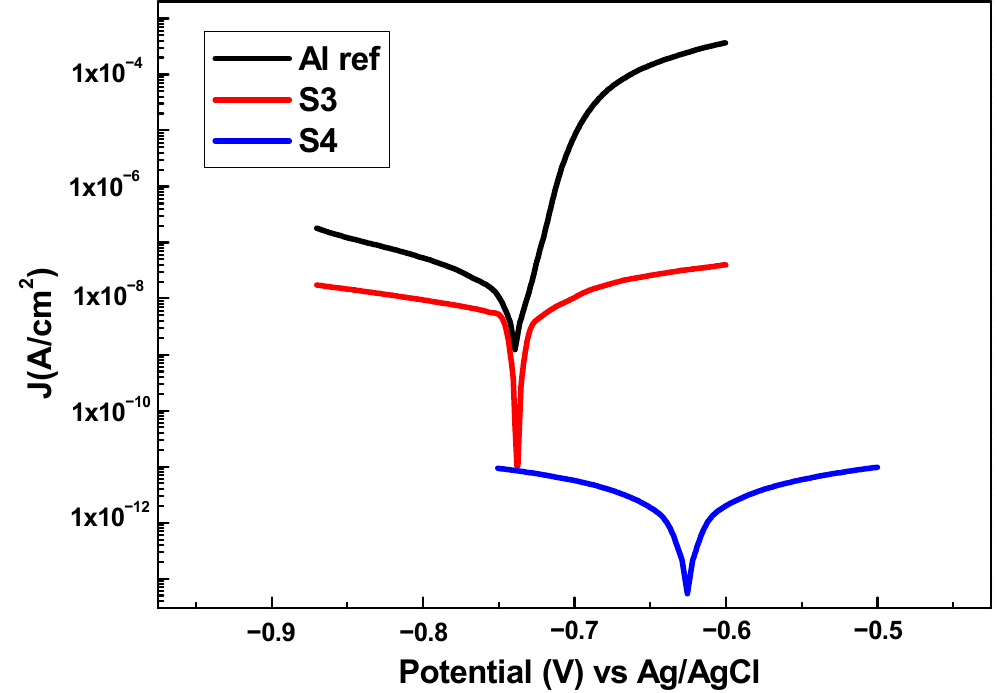
Figure 8. Tafel plots corresponding to the aluminum bare substrate and the different aluminum samples composed of PTFE composite being tested in 6 wt% NaCl aqueous solution. Table 6. Summary table of the Tafel analysis parameters obtained for uncoated aluminum substrate (6061-T6) and composite coatings (Sx). All the samples of this study have been tested in 6 wt% NaCl aqueous solution.